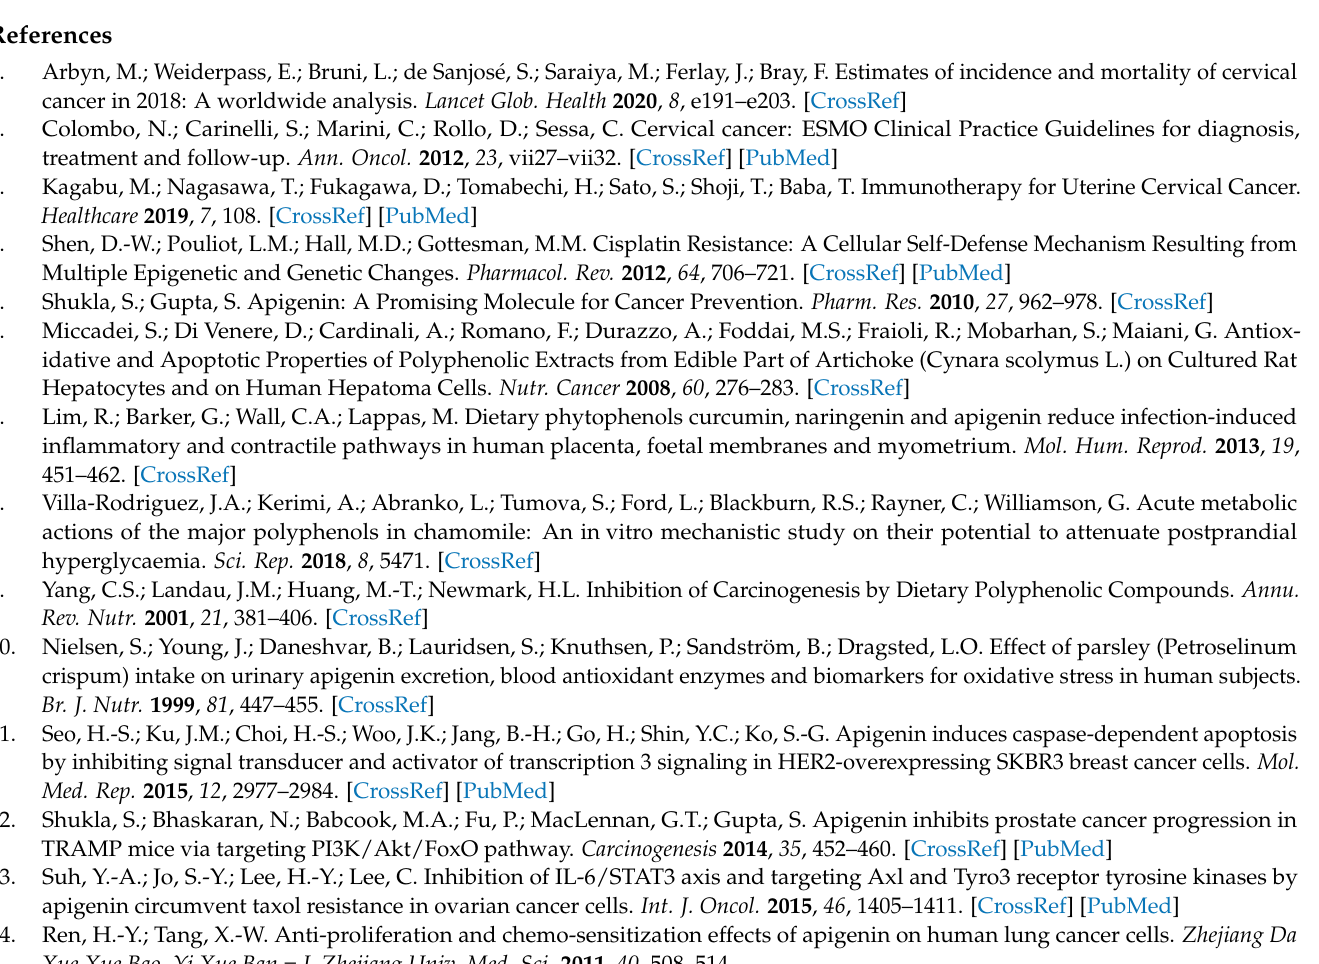
analysis. Figure S2: Apoptosis and cell cycle arrest induced by apigenin in cervical cancer cells; Figure S3: Apigenin regulated PI3K/AKT/mTOR signaling pathway; Figure S4: Apigenin inactivates the integrin β 1-FAK signaling pathway; Figure S5: Apigenin inhibits epithelial-to-mesenchymal transitional protein